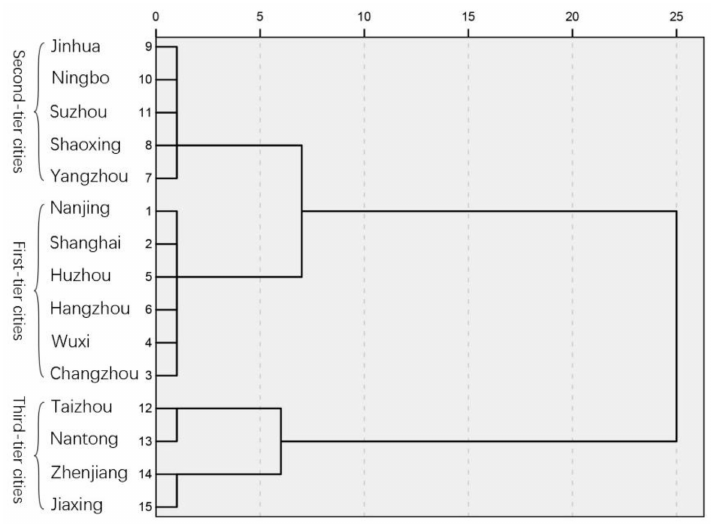
Figure 10. Cluster analysis of the ‘Smart industry’